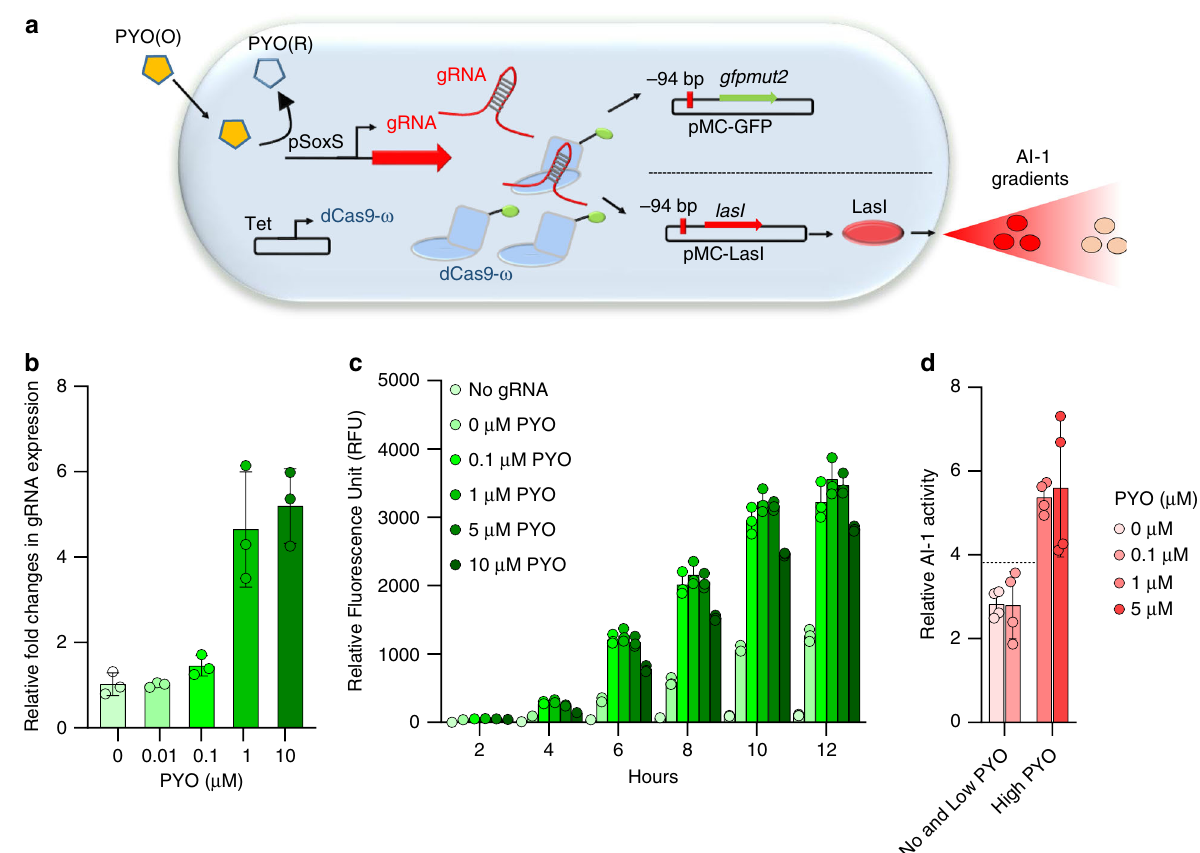
Fig. 2 Tunable CRISPRa system by controlling gRNA expression from SoxS promoters. a Scheme of a tunable CRISPRa system with the E. coli pSoxS promoter expressing gRNAs for transcriptional activation. Transcriptional activator dCas9- ω is expressed under a Tet promoter in pdCas9- ω which then combined with gRNAs from pSC-S108 to target gfpmut2 and lasI resulting in transcriptional activation of GFP and LasI in NB101 cells. Expression of LasI results in synthesis of autoinducer-1 (AI-1). b qPCR data indicating the relative levels of gRNAs after 6 h of promoter induction. c CRISPRa mediated GFP fl uorescence across 12 h measured via a plate reader. d AI-1 assay indicating the amounts of AI-1 generated via CRISPRa. AI-1 producer cells are induced with different PYO concentrations and after 4 h of induction, conditioned media from the AI-1 producer cells is collected and added to the AI-1 reporter cells. After 4 h of incubation with reporter cells, bioluminescence is measured via a luminometer. In all fi gs, independent experimental replicates are represented by circles and height of the bars indicate mean. For b and c , n = 3 and for d , n = 4. Error bars indicate standard deviation. Source data for all fi gures is provided